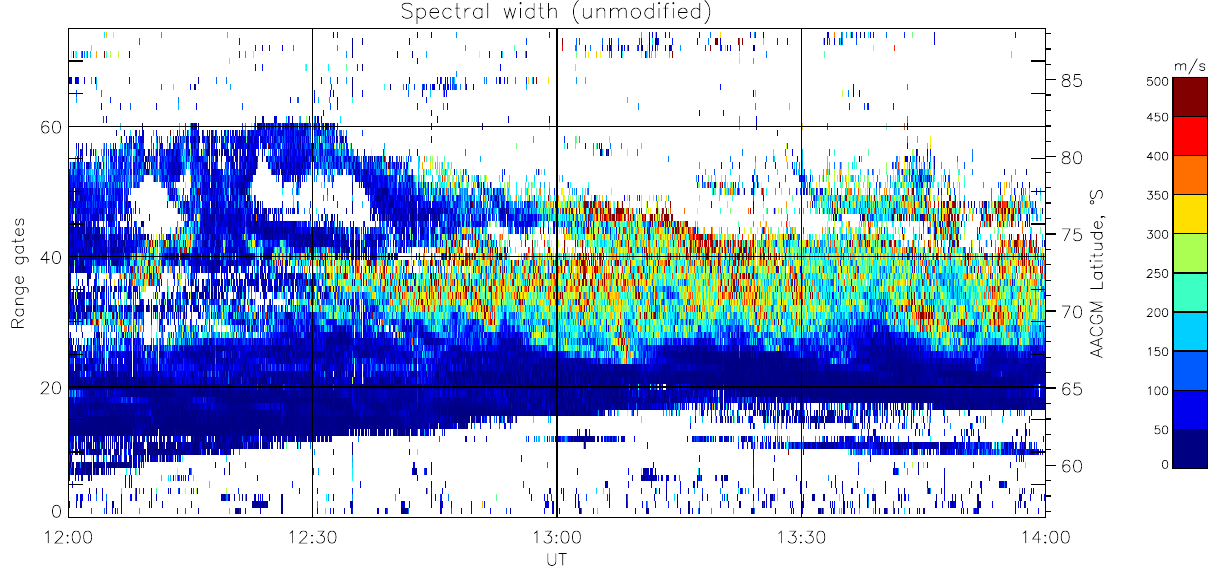
Fig. 5. Spectral width for 12:00–14:00 UT on 10 December 1999, obtained from TIGER beam #4 using the original FITACF procedure.